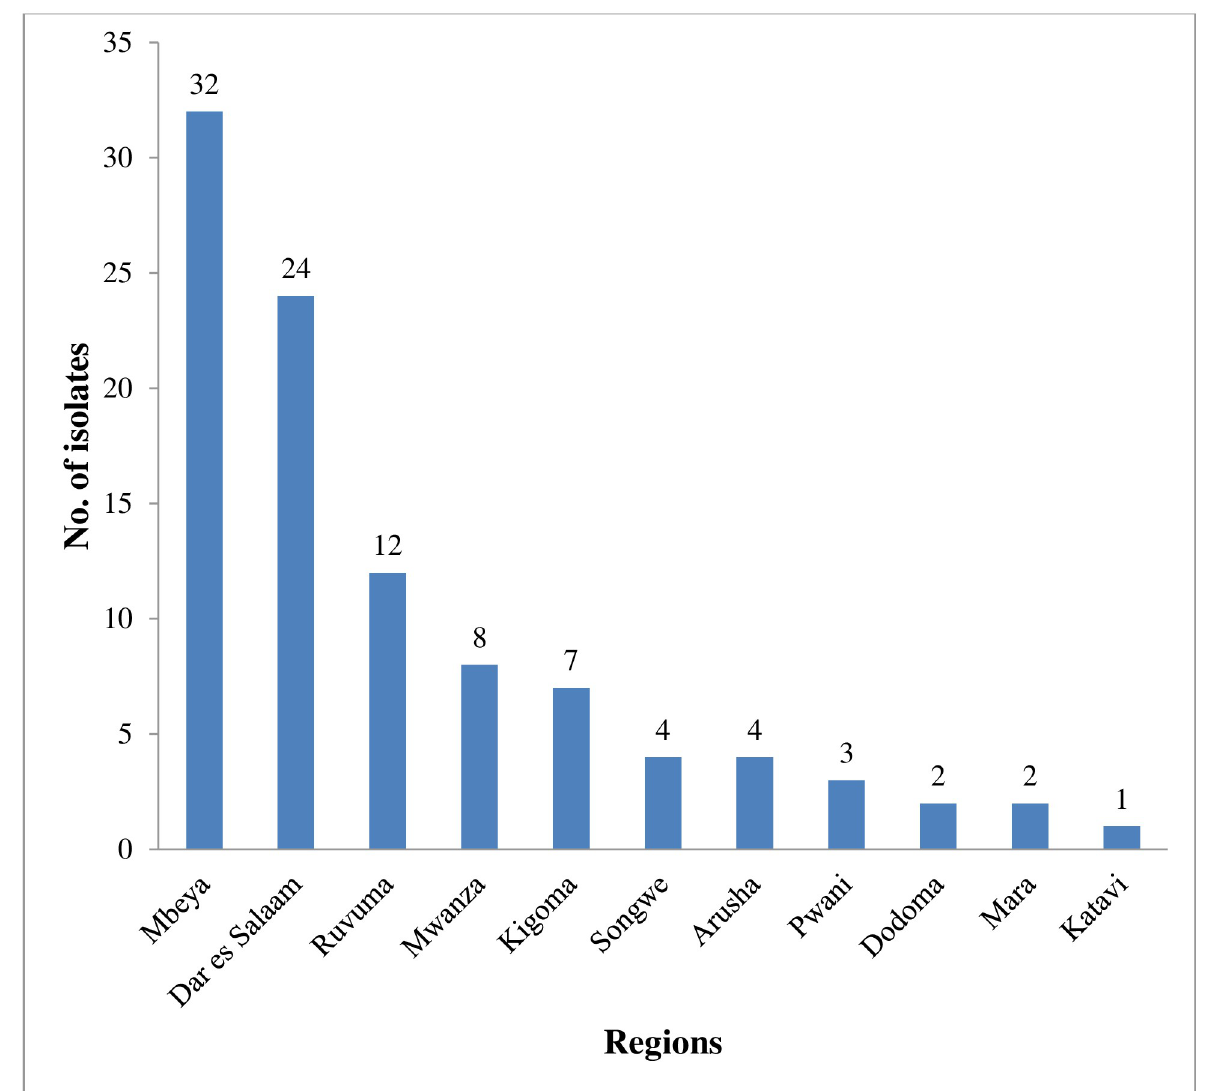
Fig 1. Distribution of laboratory-confirmed V . cholerae